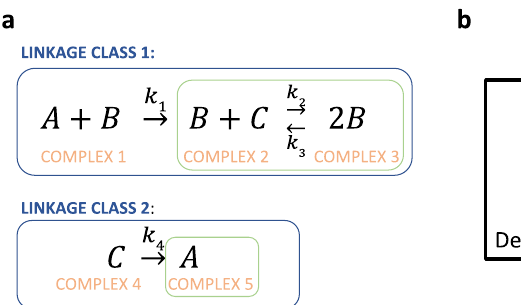
Fig. 5 | De fi ciency is a key integer invariant for a CRN. a The linkage classes of a CRN are the connected components of the CRN ’ s graph. The complexes are the vertices of the graph, while the reactions are the directed edges. Strong-linkage classes are the maximal strongly-connected subgraphs of the CRN. A terminal strong-linkage class (noted in green) is one in which no complex reacts to a com- plex in a different strong linkage class. Complexes belonging to terminal strong-